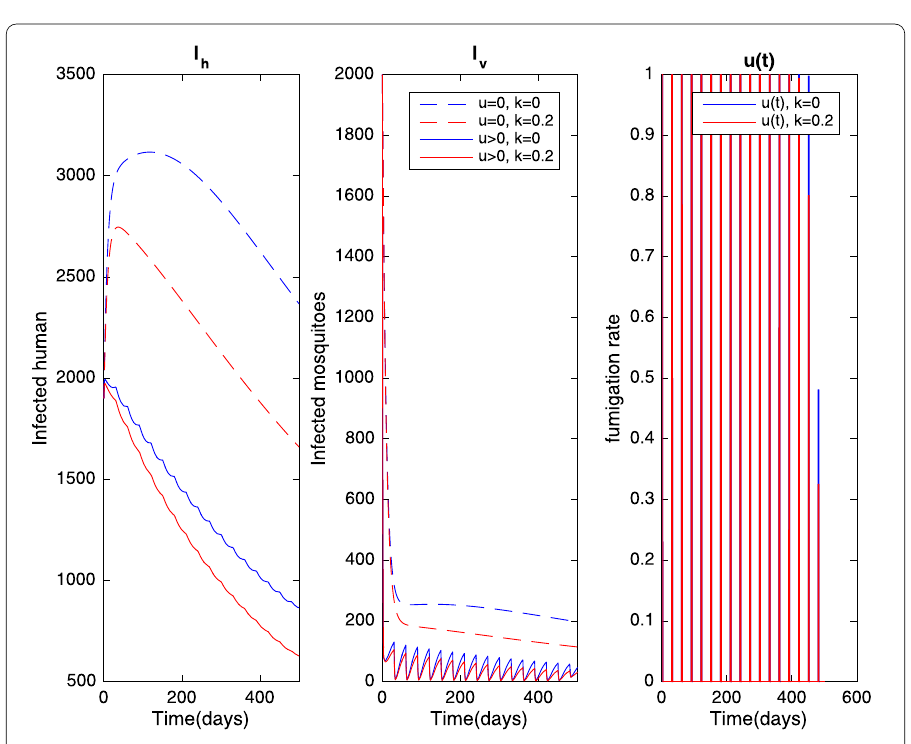
Figure 15 Results of simulations with and without fumigation intervention when k = 0 and k =